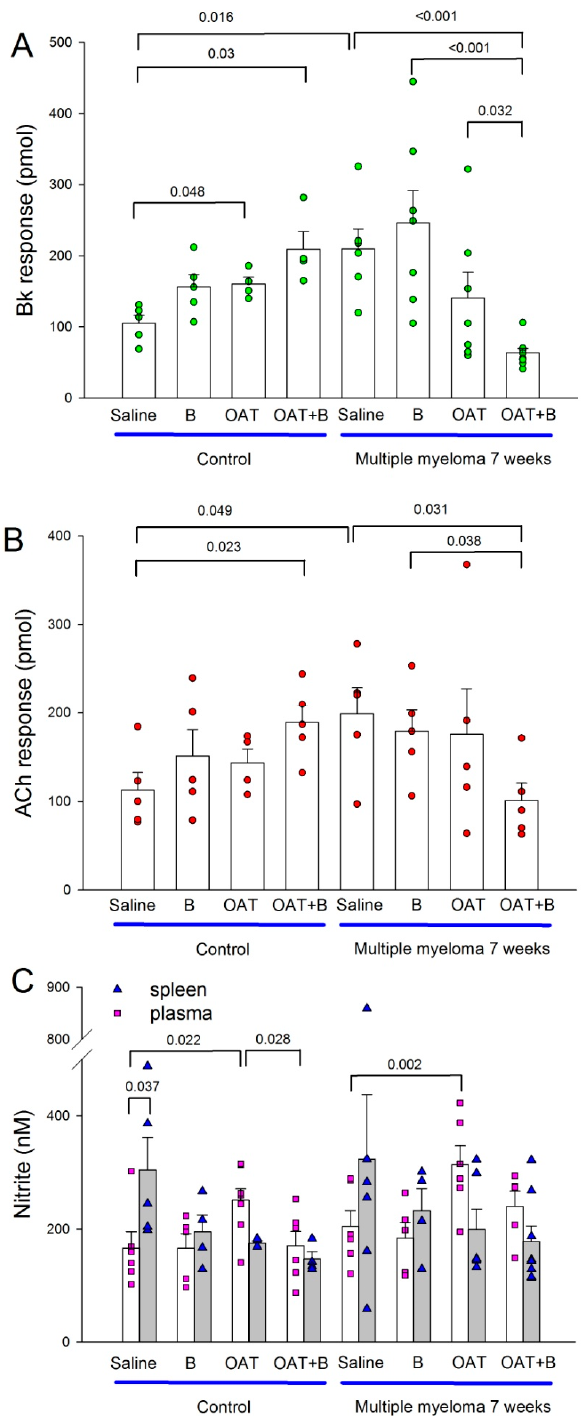
Figure 4. Effects of a proteasome inhibitor, bortezomib, arginase inhibitor, OAT-1746 and their combination on coronary endothelial function as well as plasma and spleen nitrite concentration in healthy and multiple myeloma mice. ( A , B ) show coronary endothelial function measured in Langendorff-perfused mouse hearts as an amount of nitrite in coronary effluent over 30 s after bolus injection of bradykinin (Bk response) or acetylcholine (Ach response). Individual data points represent means from 3 measurements. ( C ) presents nitrite concentration in plasma and spleen. Saline, saline-treated mice; B, bortezomib-treated mice; OAT, OAT-1746-treated mice; OAT+B, OAT-1746, and bortezomib combination-treated mice; graph presents means ± SD, n = 4–6; p values were calculated with one-way ANOVA with Dunnett’s post hoc